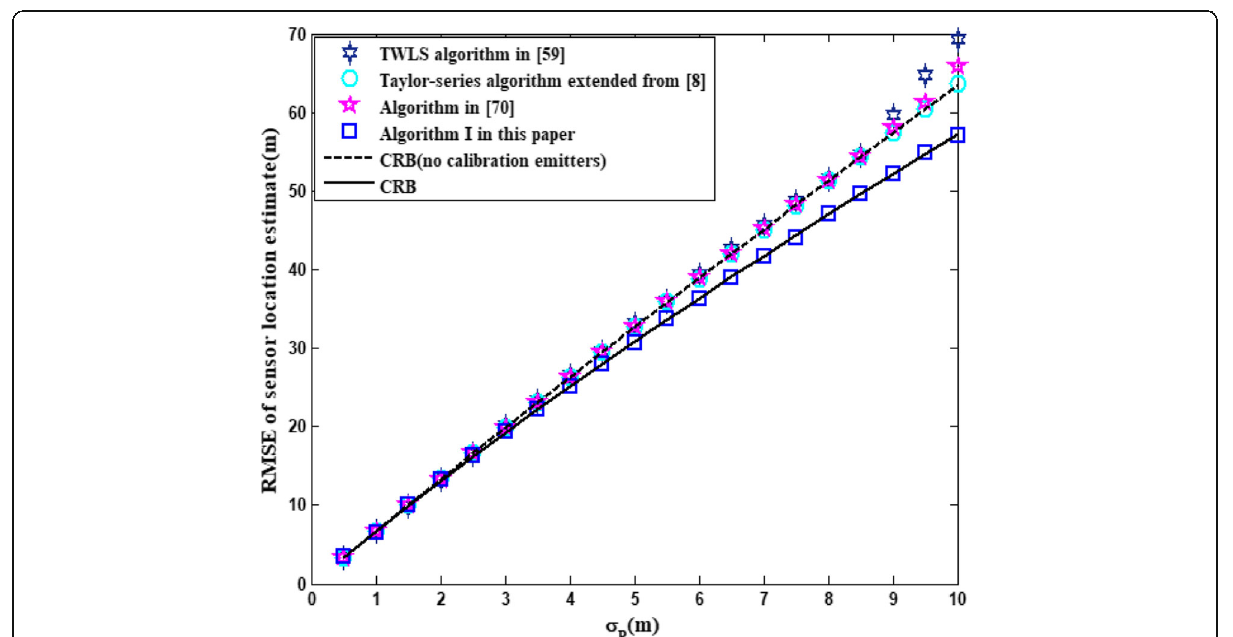
Fig. 10 RMSE of sensor location estimate versus σ